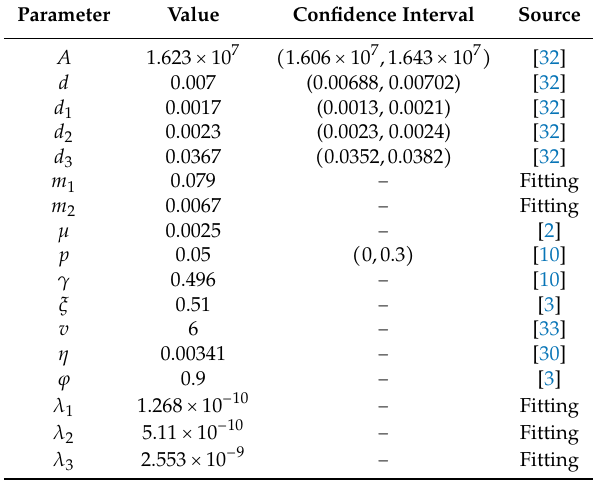
Table 2. The parameter values of Model